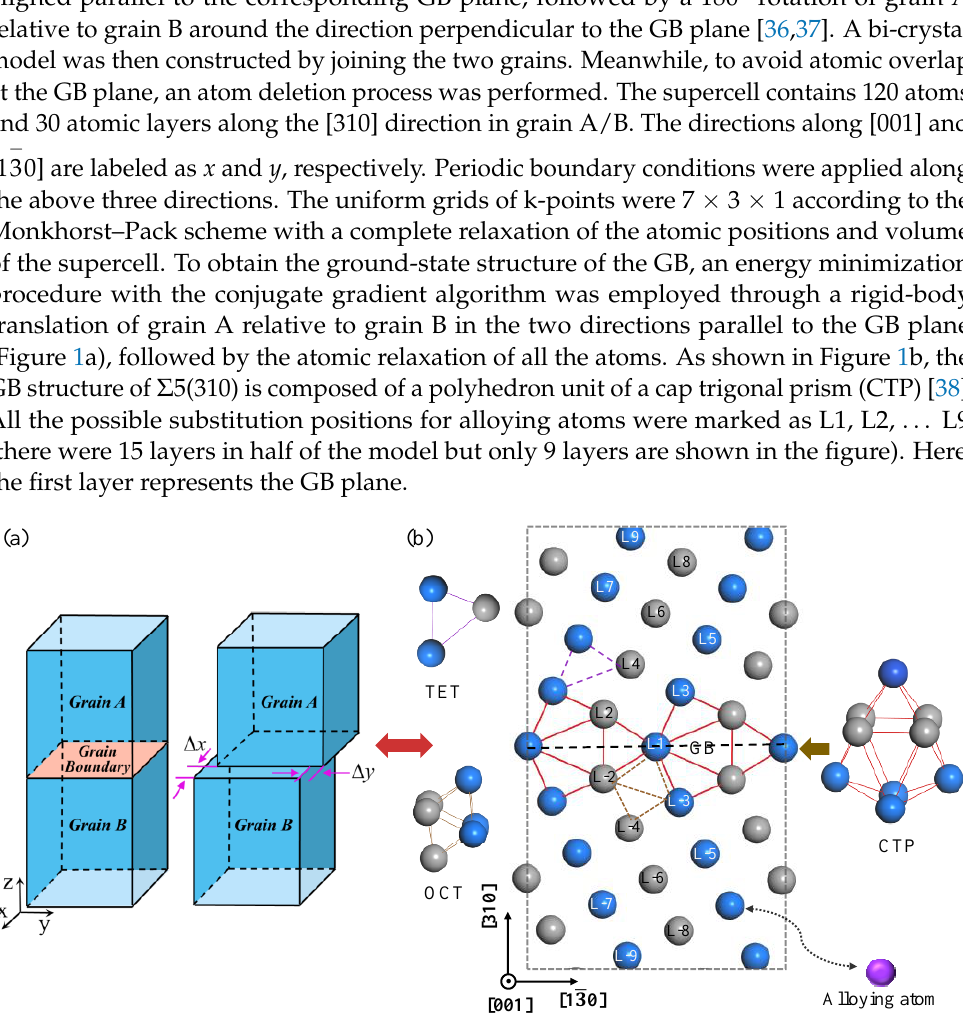
Figure 1. ( a ) 3D sketch of the construction of the grain boundary (GB) and ( b ) atomic structure and polyhedron structure units (TET, OCT and CTP) of the Fe Σ5 (310) GB. Fe atoms at different layers along the [001] direction are represented by blue and gray, respectively. The CTP structure is repre- sented by the corresponding atomic color on the GB. The purple sphere represents an alloying atom.